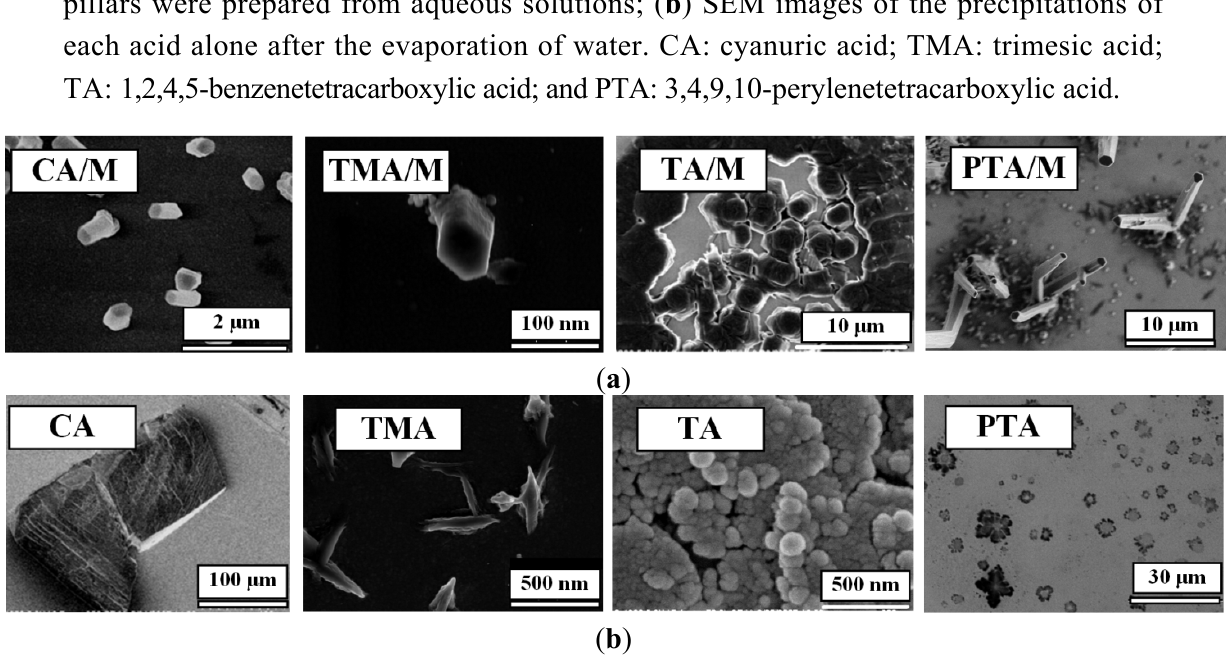
Figure 1. ( a ) Scanning electron microscopy (SEM) images of micro-/nano-pillar arrays prepared from melamine (M) with a series of acids (0.001 M in water) on gold. All of the